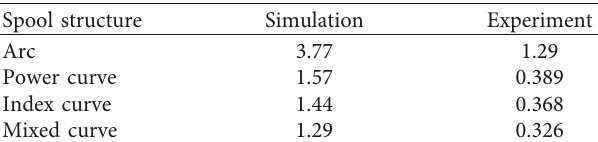
Table 3: Sum of squares of residuals for experiment and simulation ( × 10 − 3